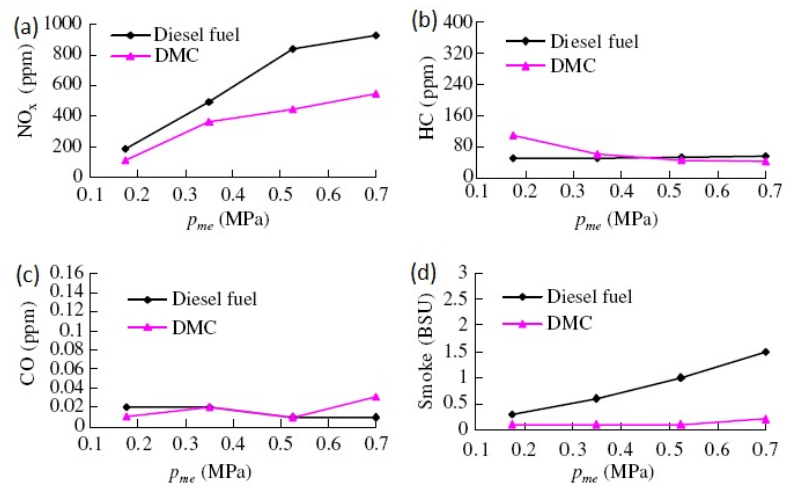
Figure 4. Comparison of the ( a ) NO x , ( b ) HC , ( c ) CO , and ( d ) smoke emissions at different loads for DMC and base fuel